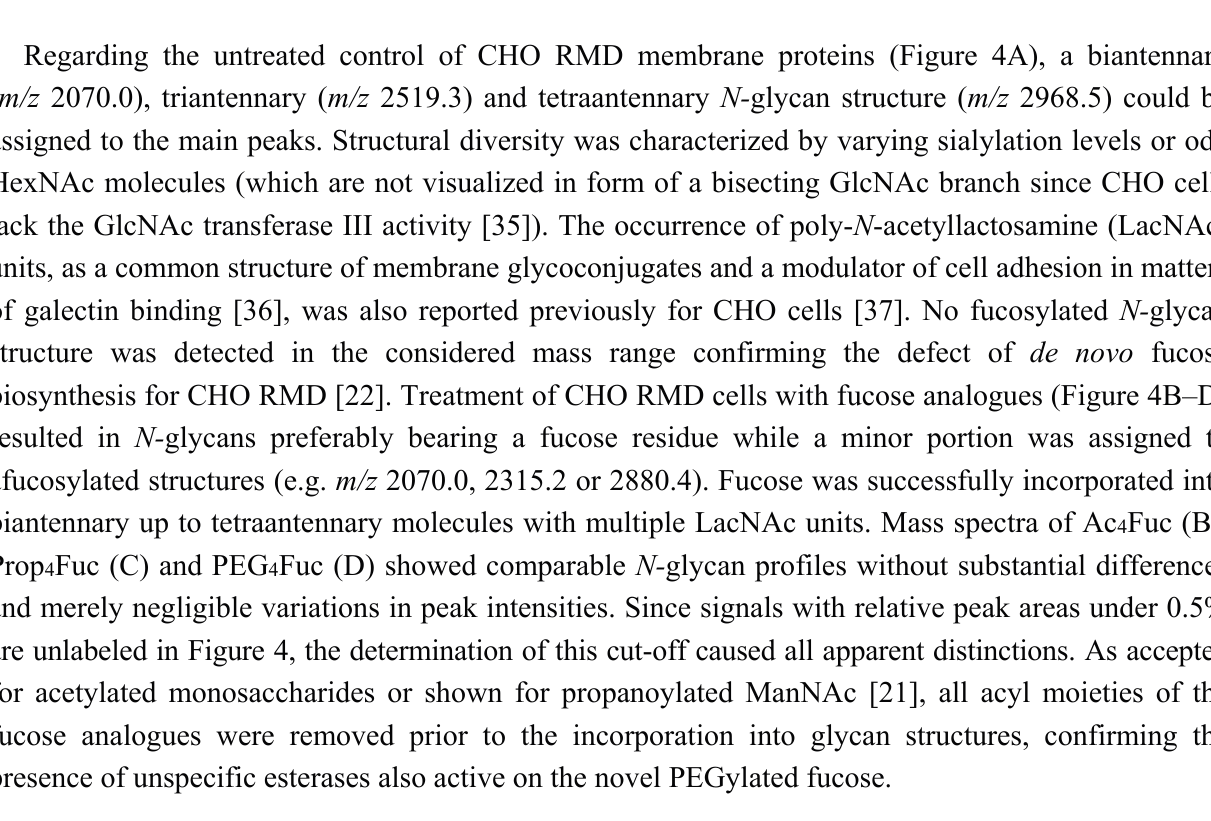
Figure 3. Lectin blot analysis of CHO RMD membrane proteins. Cells were treated with 80 µM of the respective fucose analogue under serum-free conditions for three days prior to an isolation of membrane proteins. 2 µg of the protein samples were separated by reducing SDS-PAGE, electroblotted and probed with AAL-I. An untreated CHO RMD sample served as